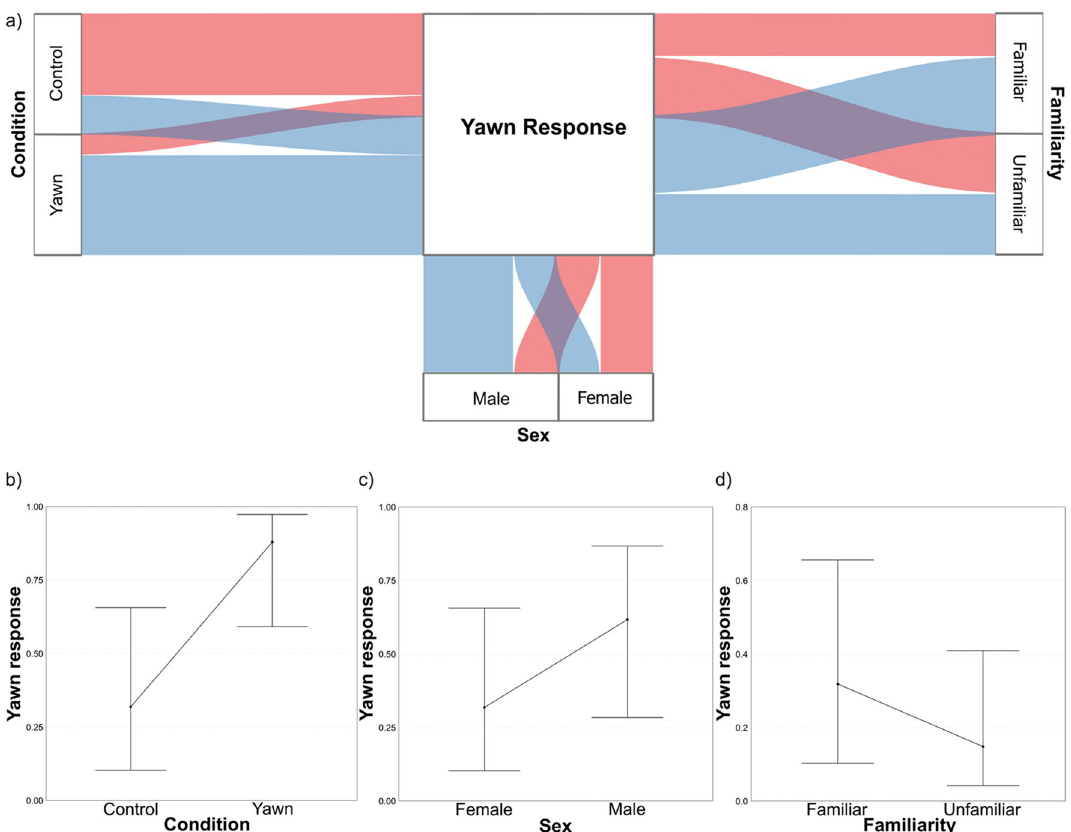
Figure 3. Results of Model 2c (Yawn Response as response variable) showing the effect of the significant predictors. ( a ) Alluvial plot showing the occurrence of Yawn Response (Blue streams = presence; Pink streams = absence) for each level of the factors “Condition” (Yawn vs Control), “Sex” (Male vs Female), and “Familiarity” (Familiar vs Unfamiliar). ( b ) Effect of the variable Condition on the Yawn Response; ( c ) Effect of the variable Sex on the Yawn Response; ( d ) Effect of the variable Familiarity on the Yawn Response. Bands represent the confidence